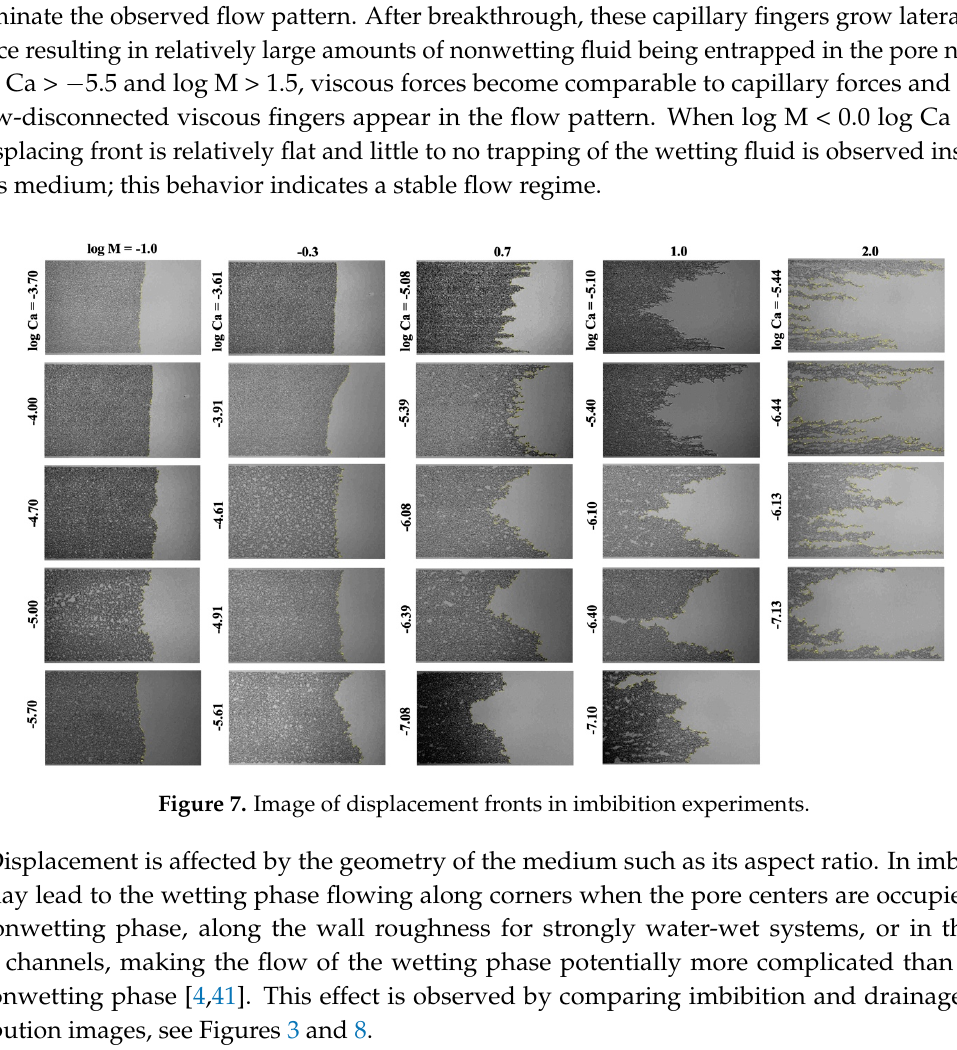
Figure 7. Image of displacement fronts in imbibition experiments.